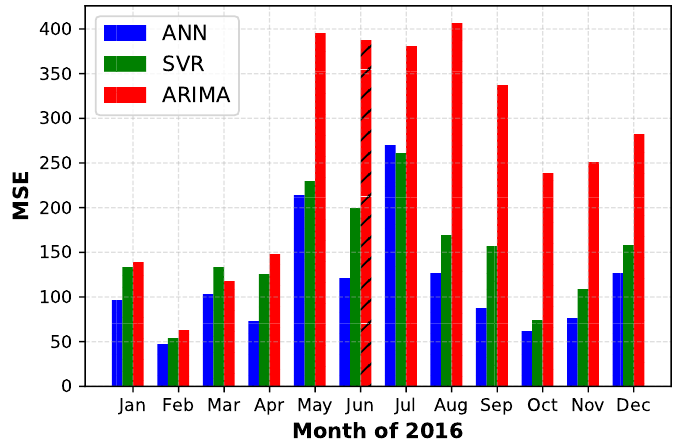
Figure 22. Performance comparison between the ANN model, SVR model and the ARIMA(1,1,1) model for the entire year of 2016 aggregated by